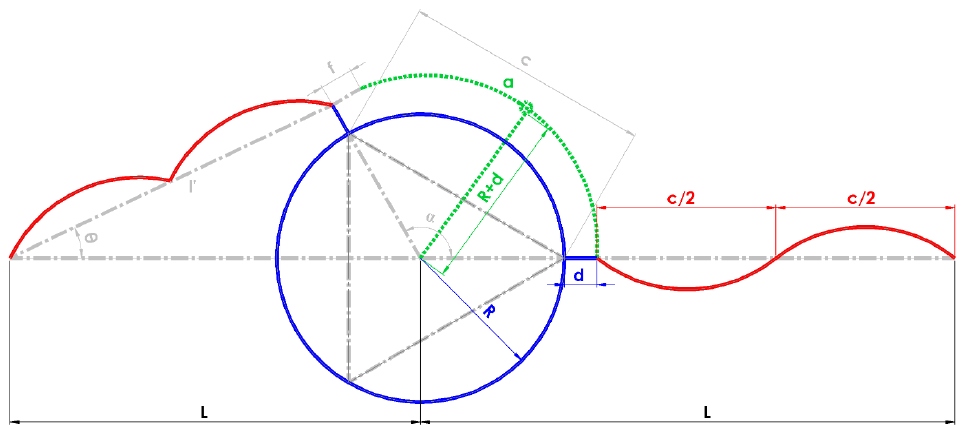
Figure 3. A scheme for dimensional